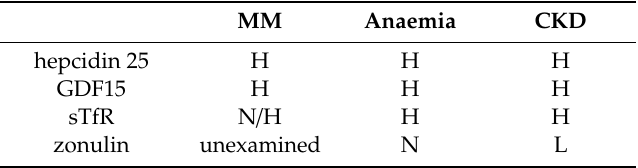
Table 3. Change in serum levels of hepcidin, GDF15, sTfR and zonulin with respect to renal disease, anaemia and multiple